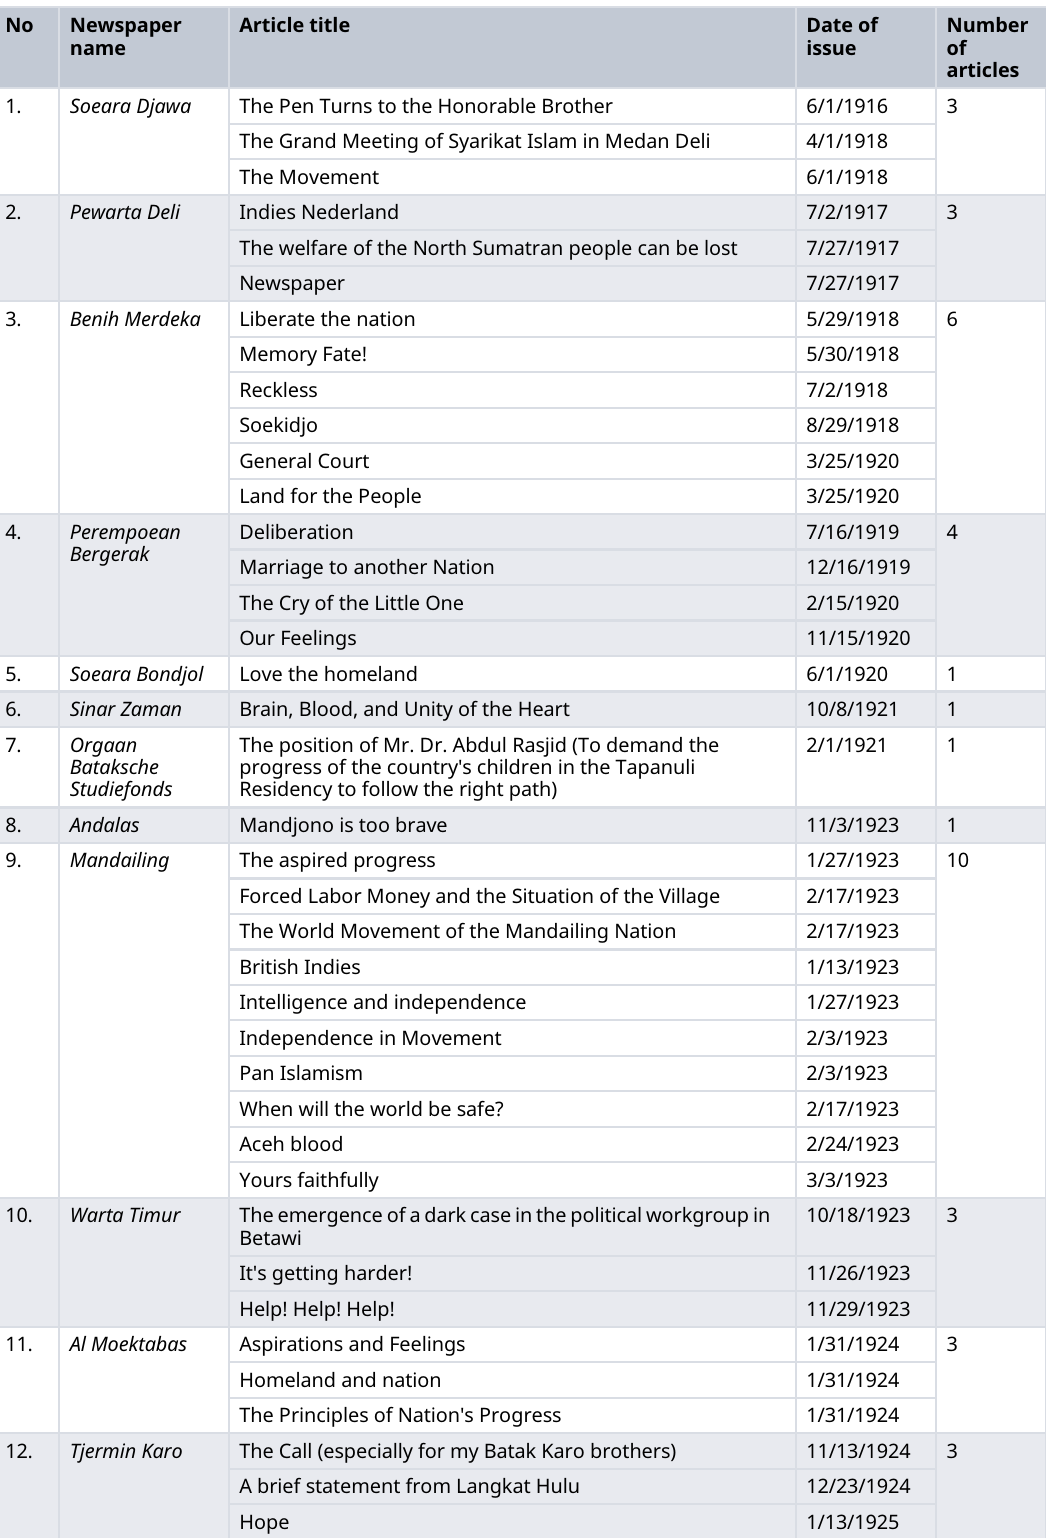
Table 3. The result of the analysis of macrostructure, superstructure, and microstructure from indigenous newspapers in North Sumatra in 1916-1925.